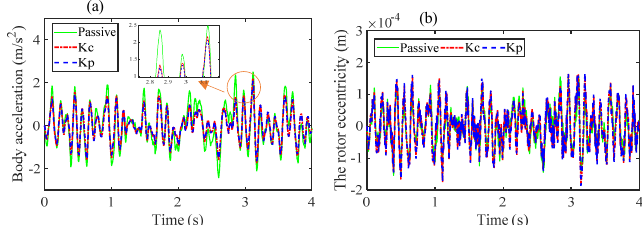
Figure 17. The responses under stochastic excitation: ( a ) body acceleration; ( b ) the rotor eccentricity. Table 1. The root mean square (RMS) of electric vehicle (EV) responses. Dynamics Response Passive Active Suspension Kc K P